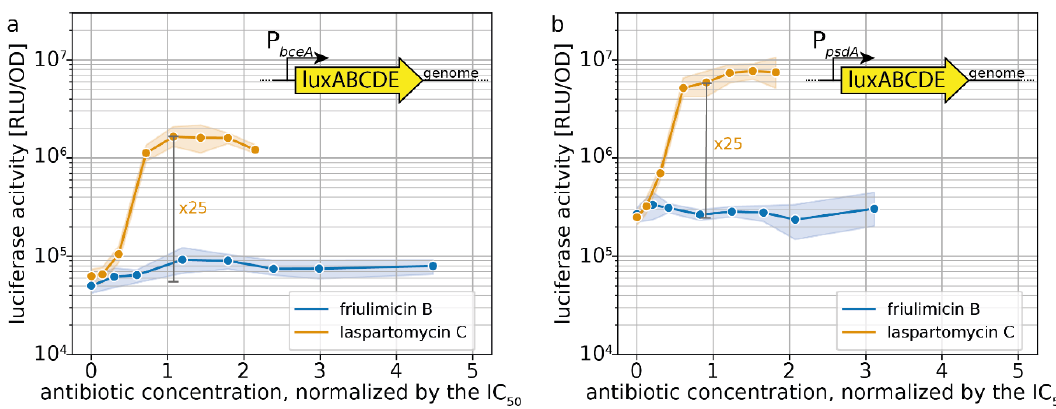
Figure 7. Sensitivity-normalized dose-dependent stress response of bce-like modules as shown by P bceA ( a ) and P psdA ( b ) promoter activation during friulimicin B and laspartomycin C attack. The relative antibiotic concentration in respect of their IC 50 is given. The induction at the IC 50 is indicated in grey, and the fold change is given. Measurements were taken 30 min after antibiotic challenge. Shaded areas depict 95% confidence intervals.